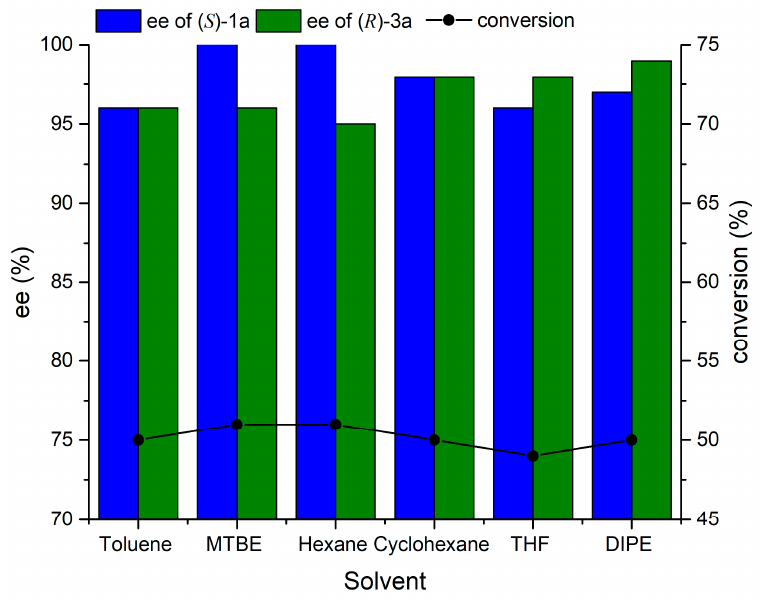
Figure 2. The effect of organic solvents on the kinetic resolution of racemic alcohol 1a in the process of transesterification with vinyl propionate catalyzed by LU ‐ CNBr (24 h reaction, 0.06 U of enzyme).